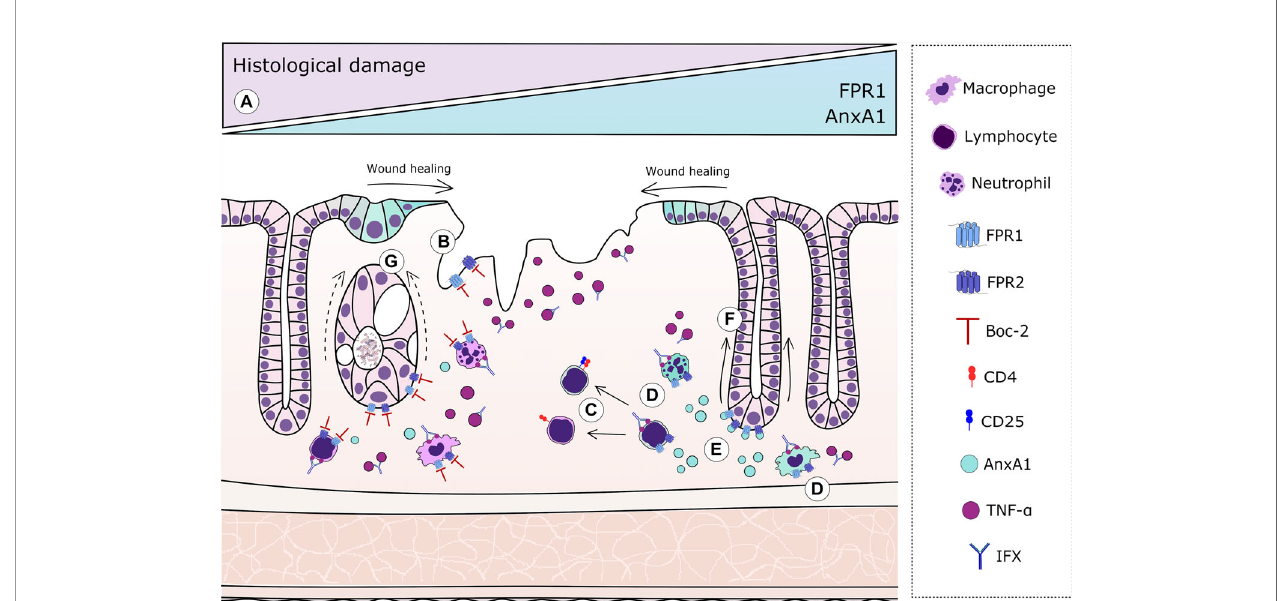
FIGURE 5 | Graphical representation of the resolutive effects of the annexin A1 (AnxA1) – formyl peptide receptor (FPR) axis complementary to in fl iximab (IFX) mechanisms. In humans : (A) Increased expressions of FPR1 and AnxA1 in colonic epithelial cells and lamina propria leukocytes correlate with histological remission after IFX. In mice : (B) AnxA1 expression is evoked in epithelial cells from damaged areas, but blockage of FPRs impairs proper re-epithelization. (C) In tissue T lymphocytes, the absence of endogenous AnxA1 skews cells to a more pro-in fl ammatory pro fi le, resulting in the decreased number of regulatory T cells (Tregs). (D) Immune cells transmigrated to the intestinal tissue are important sources of AnxA1 after IFX. (E) IFX induces AnxA1 secretion to the in fl ammatory milieu, which correlates with histological recovery. (F) In IFX-treated colitis, proper signaling of FPRs is crucial to adequate crypt regeneration. (G) Blockade of FPRs impairs the ability of IFX to protect glandular cells and restore the characteristic U-shape of crypts, producing amorphous structures after loss of basal – apical orientation and b - actin/villin